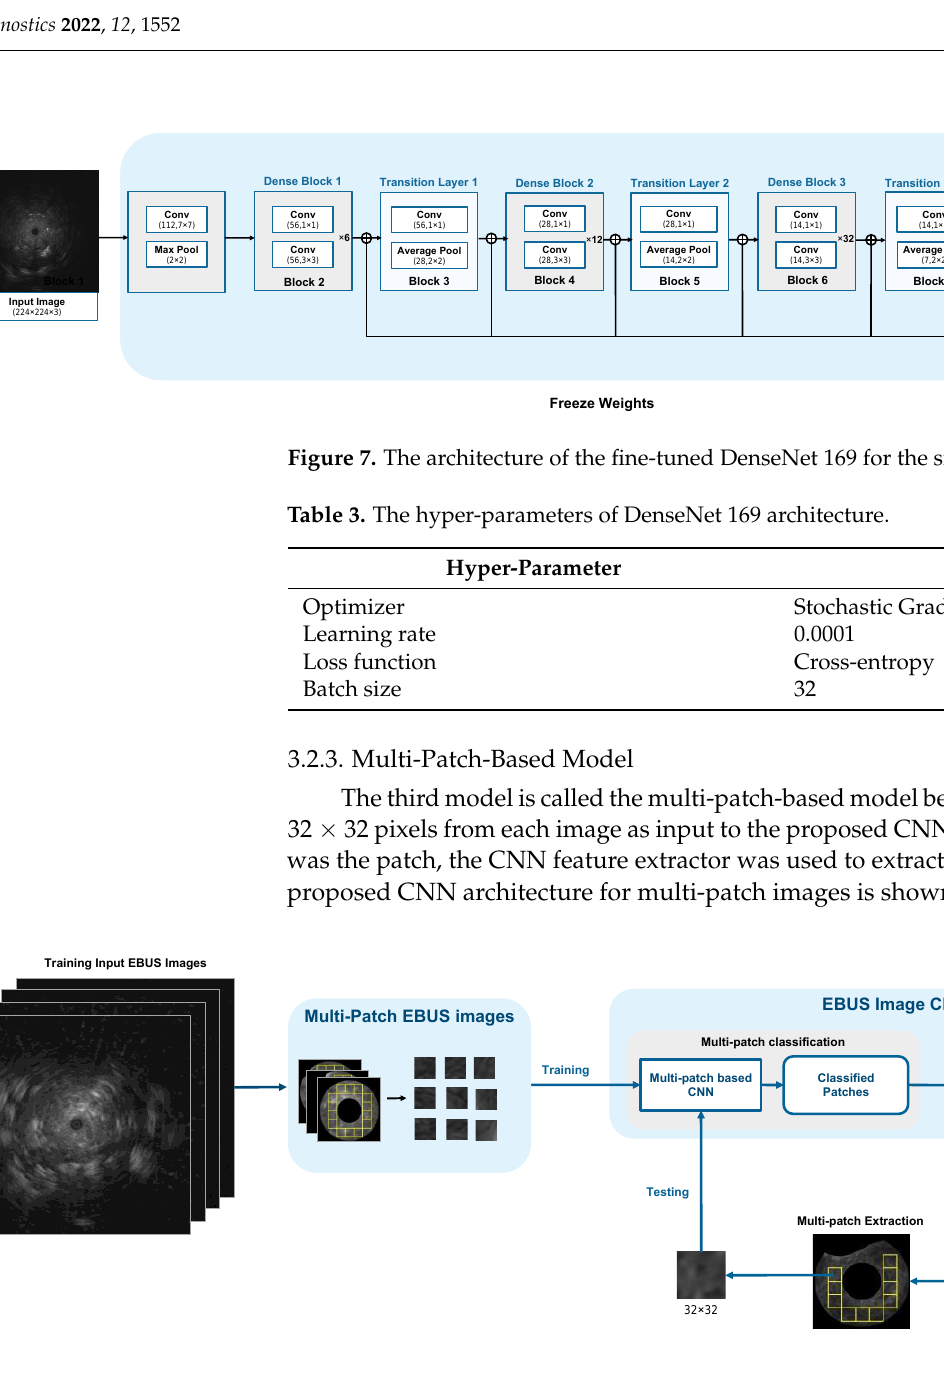
Figure 8. The architecture of the multi-patch-based model.